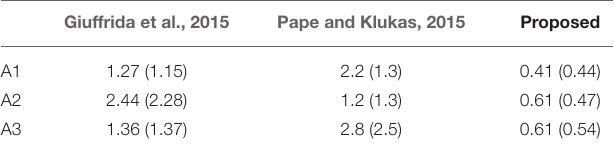
TABLE 2 | Mean (std) absolute difference for the three leaf counting